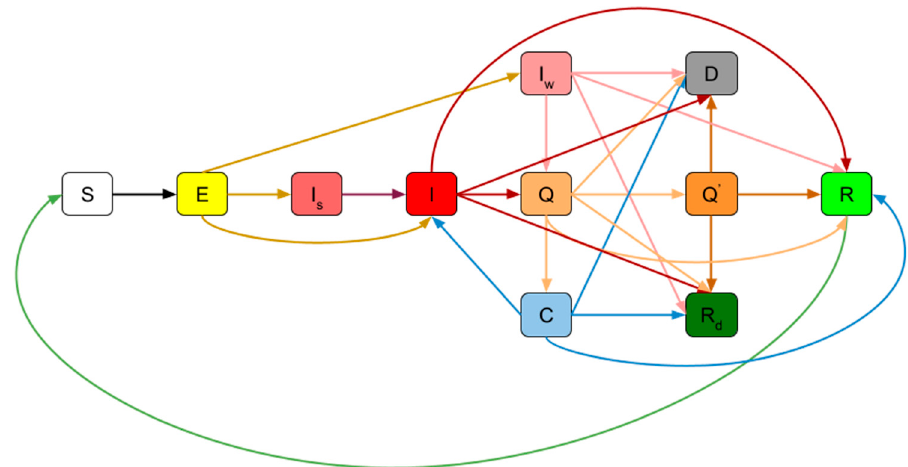
Figure 1. A schematic view of the proposed SIR model: susceptible (S), non-contagious (E), infected people who ignore the symptoms (I_s), infected (I), asymptomatic infected (I w ), in quarantine (Q), in the intensive care unit (Q’), carriers (C), recovered (R), recovered immobilized (R d ), deaths (D).